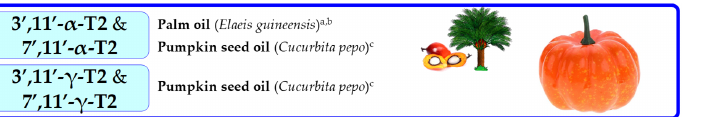
Figure 9. Sources of tocomonoenols (T1s). Superscripts ( a–f ) refers to the following literature posi- tions: a , [70]; b , [71]; c , [75]; d , [73]; e , [16]; f , [74].